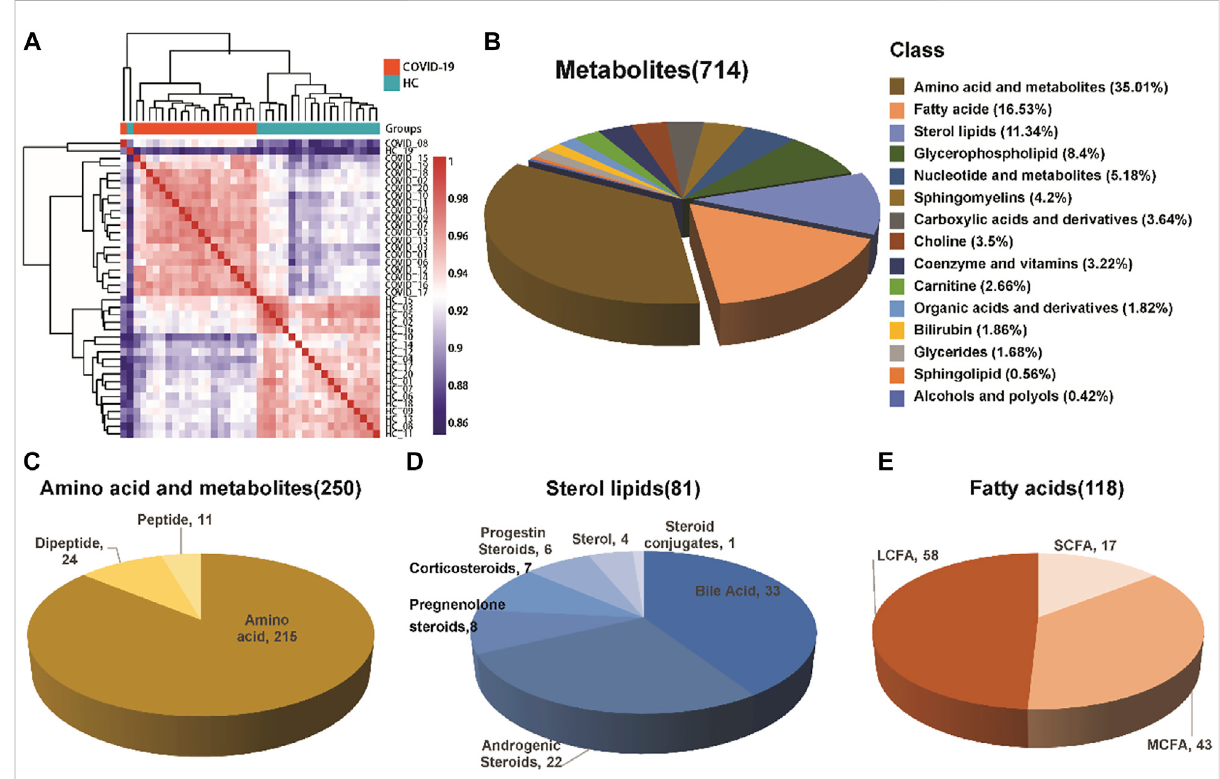
FIGURE 1 Composition of serum metabolites. (A) Correlation coef fi cient test between the healthy control group and COVID-19 group. (B) Classi fi cation and proportion of metabolites. (C – E) Variety of major metabolites, including amino acids and their metabolites, fatty acids, and sterol